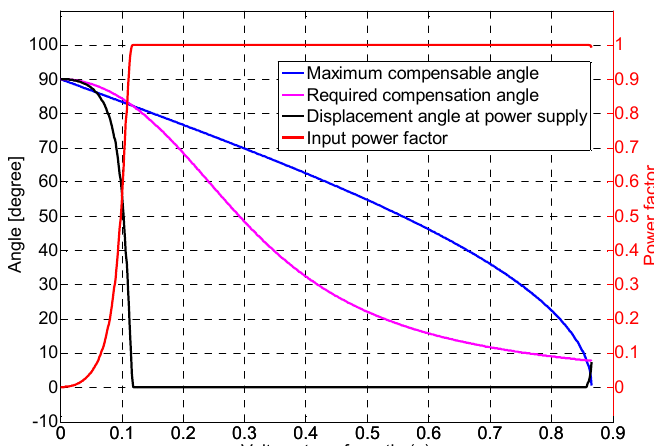
Figure 8. Maximum allowable compensated angle, required compensation angle, displacement angle, and input power factor at the main power supple at Q = 0.1.